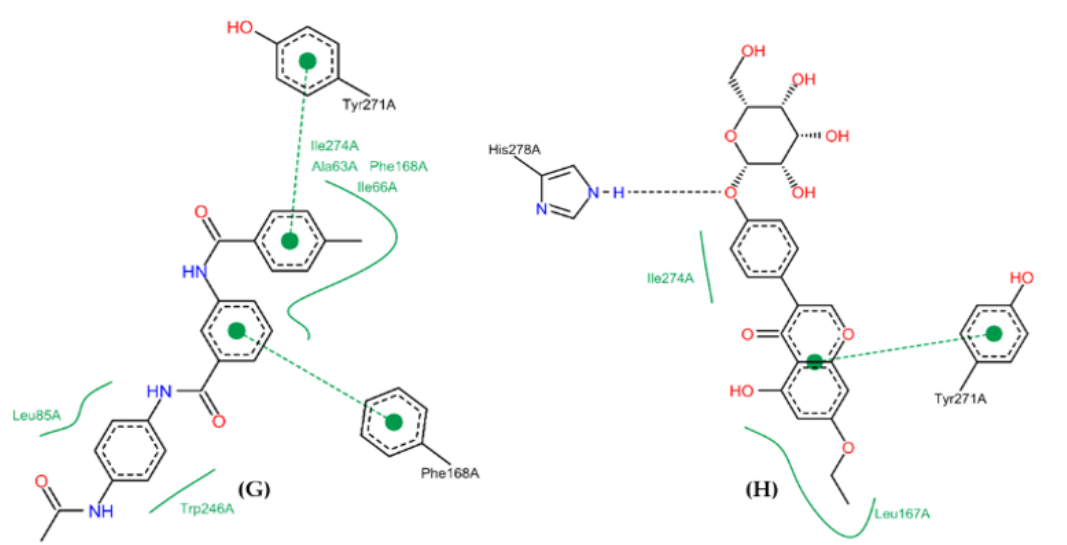
Figure 11. Binding profile for Diverset EXP 7928320 ( G ) and ZINC04257548 ( H ) with the human adenosine A 2A AR receptor, Protein Data Bank (PDB ID 3QAK). Figure generated using the Poseview webserver.